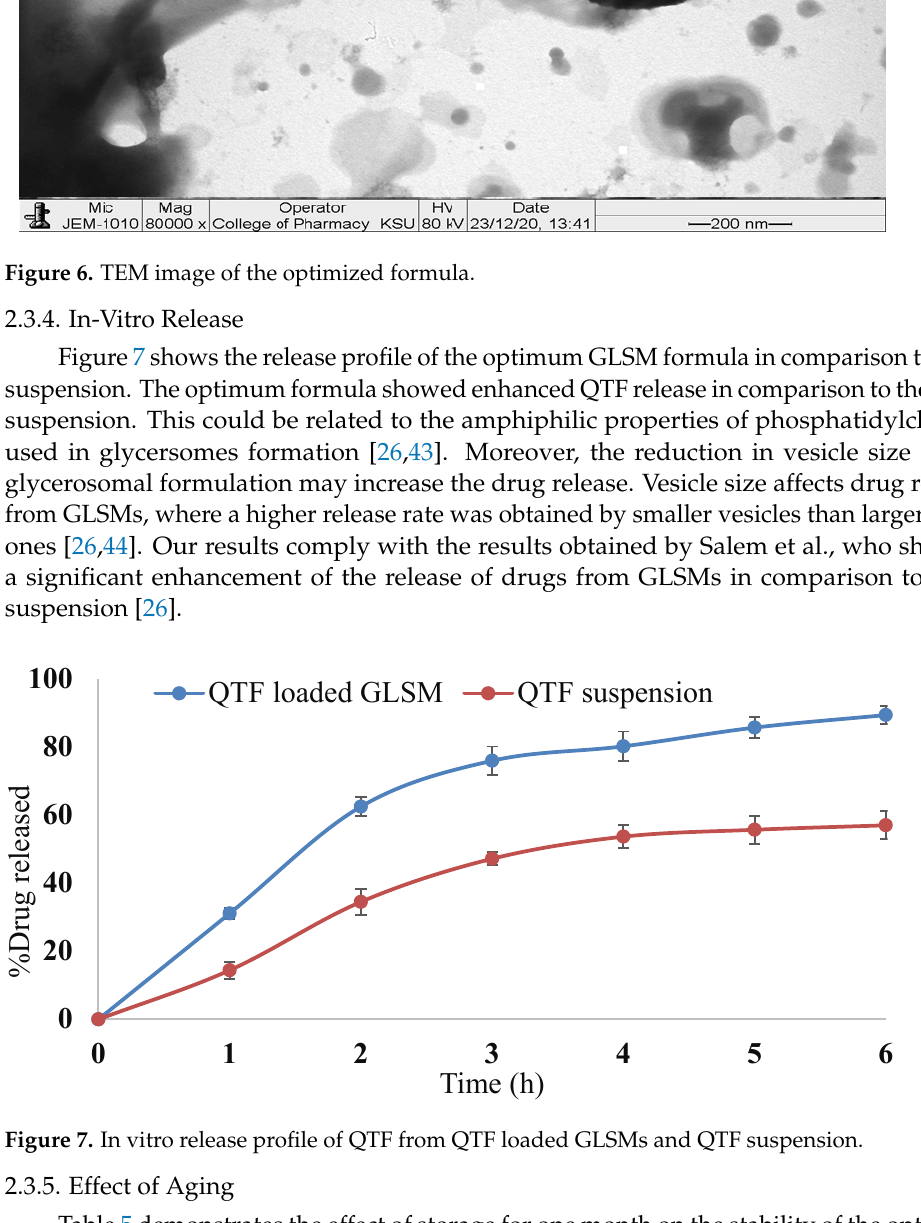
Figure 5. XRD of ( A ): pure QTF, ( B ): the optimized formula.